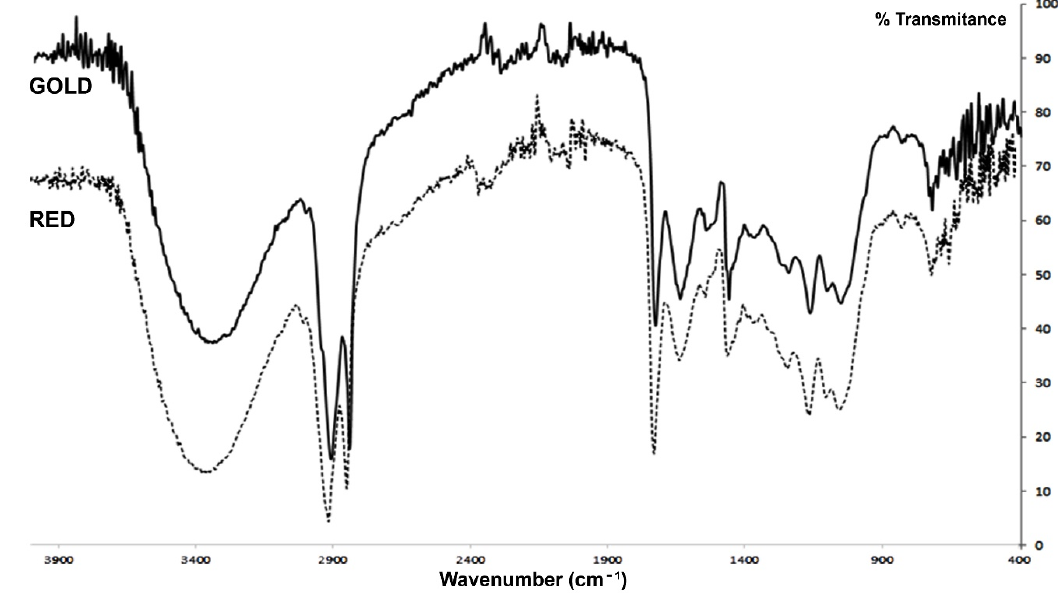
Figure 2. Attenuated total reflection infrared spectroscopy (ATR-FTIR) spectra of cutins from “golden delicious” and “red delicious” apples. Table 1. Identification of the main compounds in the soluble fraction of the alkaline hydrolysis.